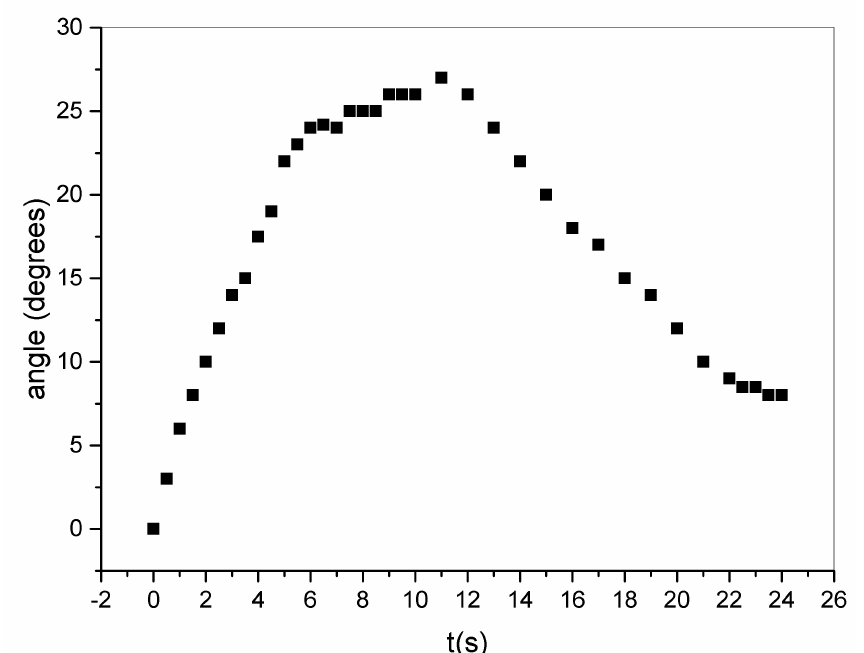
Figure 2. Behavior of the t-PMP under heat radiation. Bending ( ◦ ) vs. time